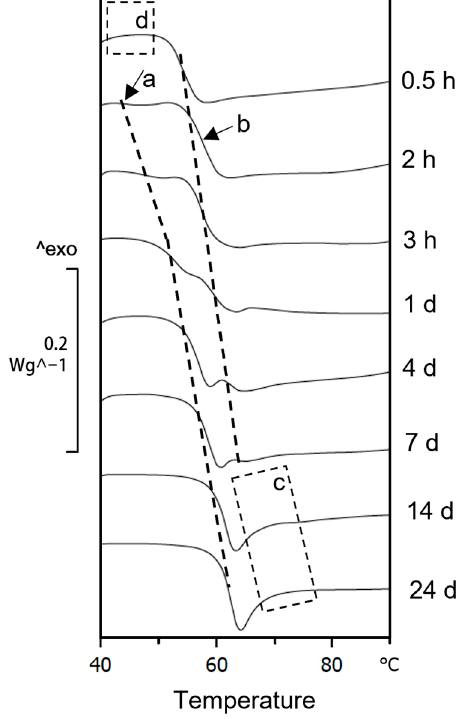
Figure 4. Detail of DSC scans at 10 ◦ C/min of PLA 4043D samples aged at 20 ◦ C, for illustrating the double T g observed: (a) hidden T g1 on PLA right after it was printed, which was used to determine the maximum temperature at which the material could be aged and highlight the importance of studying aged materials; (b) second glass transition, T g2 ; (c) missing T g2 ; (d) missing T g1 .